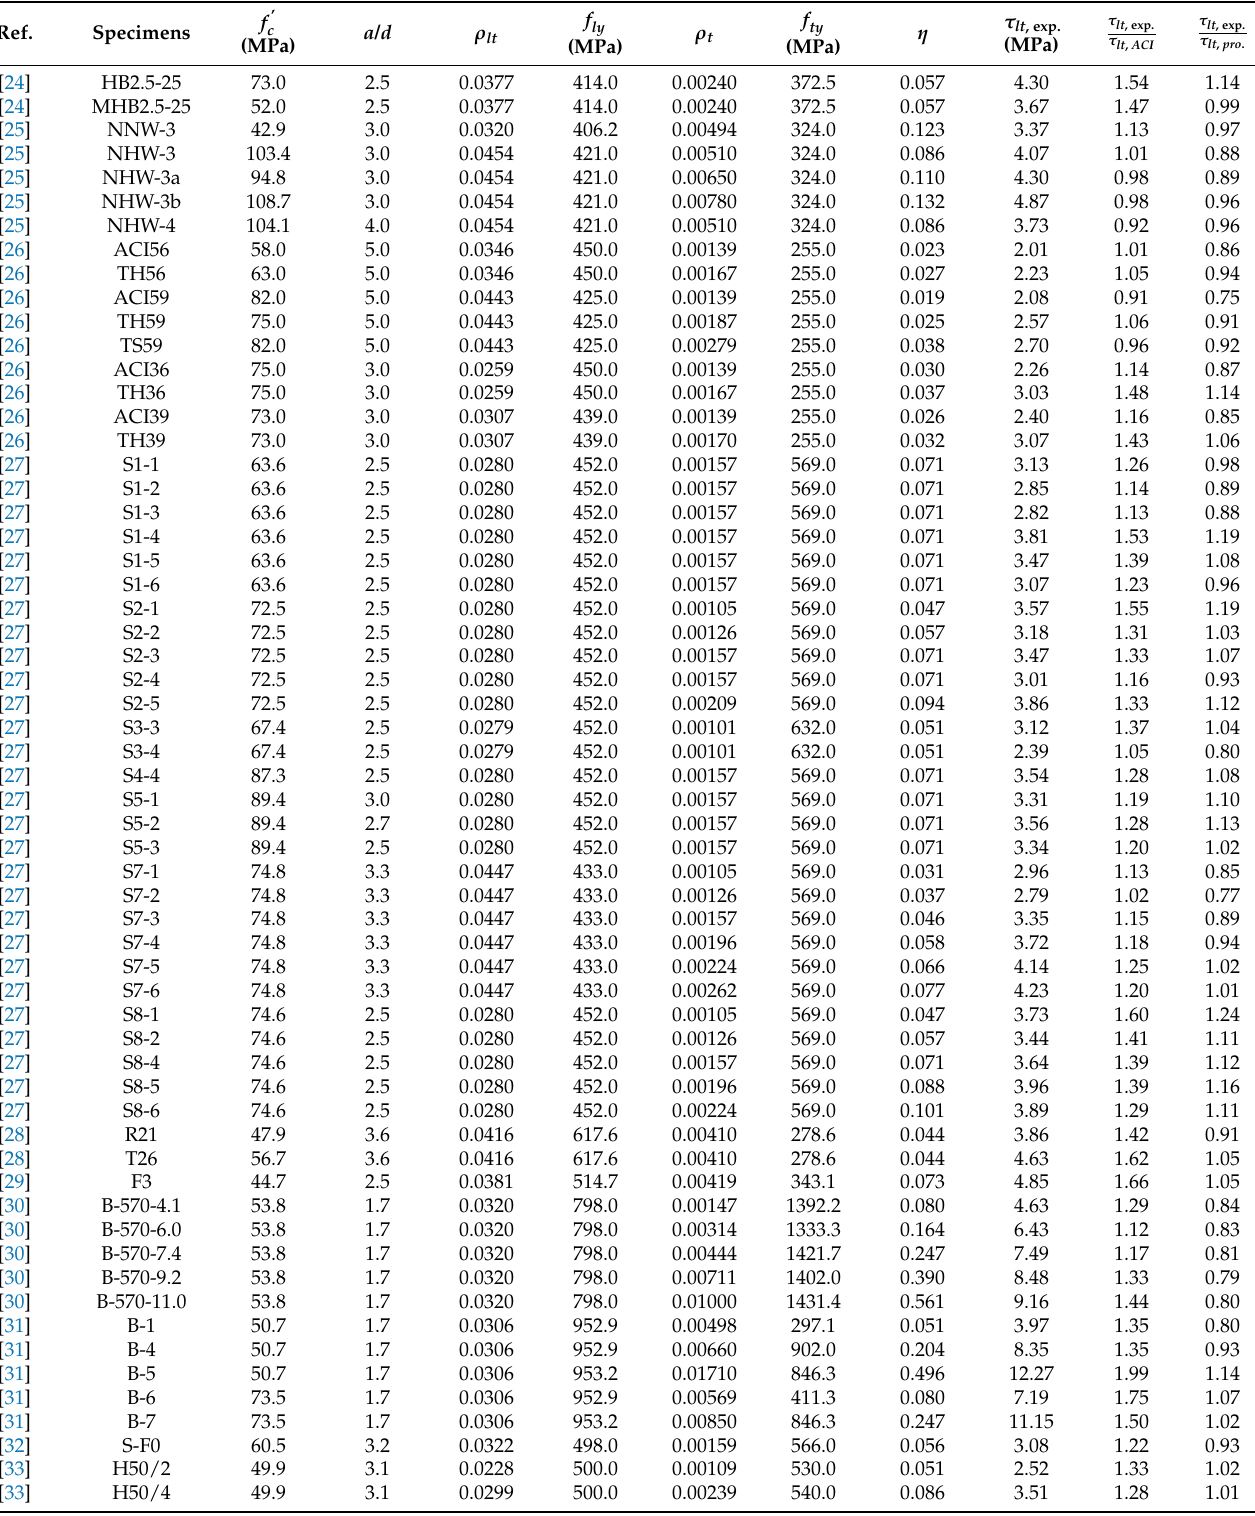
Table 1. Details of specimens collected in the literature and experimental and analytical results.